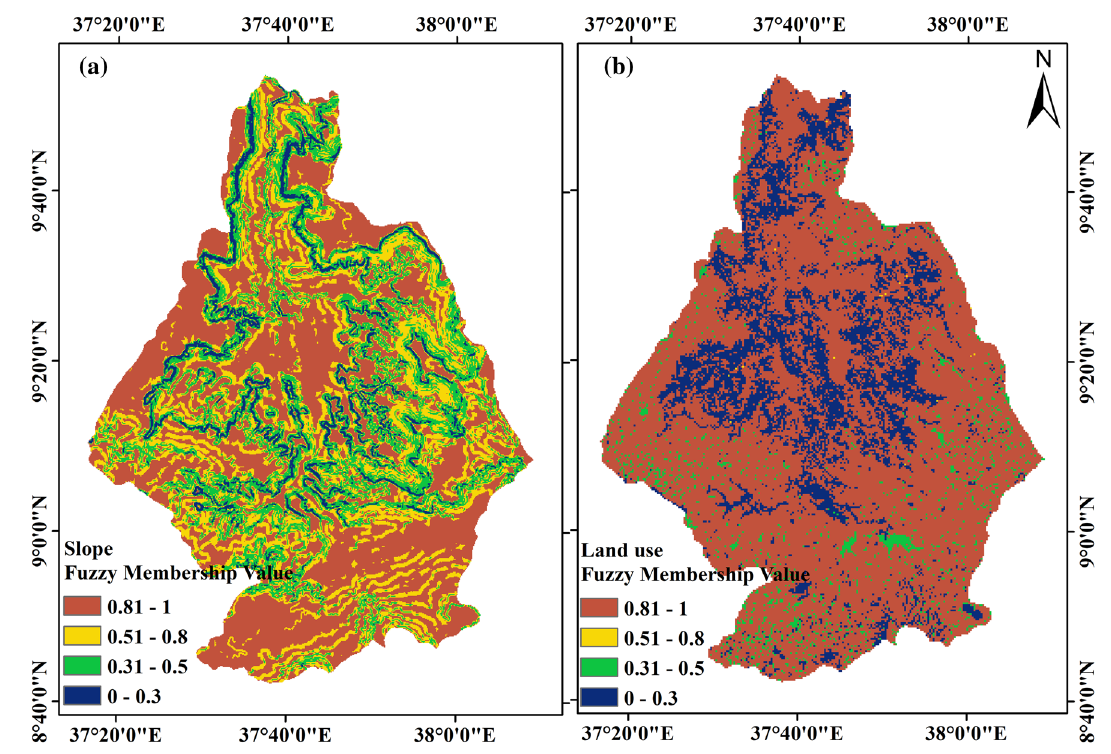
Fig. 9 Fuzzy membership values for a slope, b land use